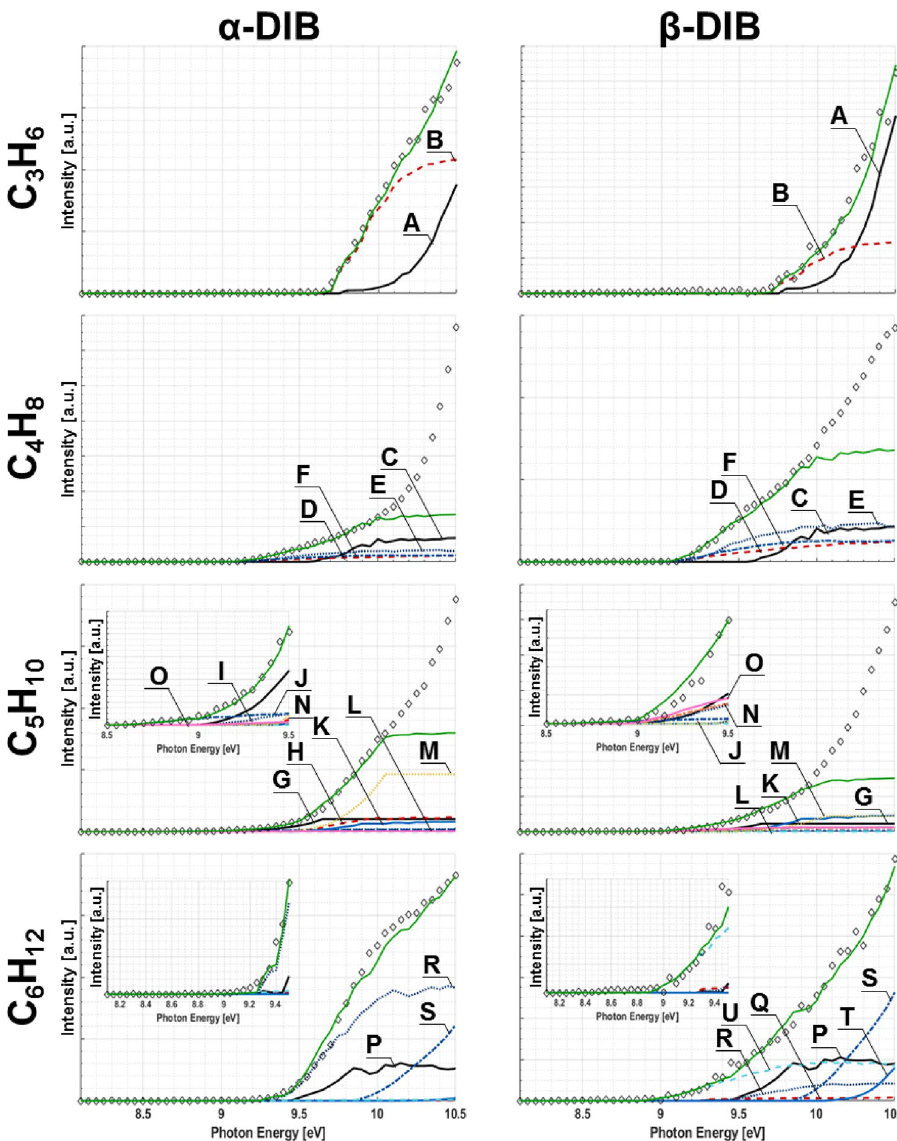
Figure 6. Intensity curves measured “ ◇ ” for non-oxygenated species in α- and β-DIB reactions. Colored traces correspond to those for species from Table 3, while green is reserved for the fit to experiment. Where appropriate, the inserts show magnified